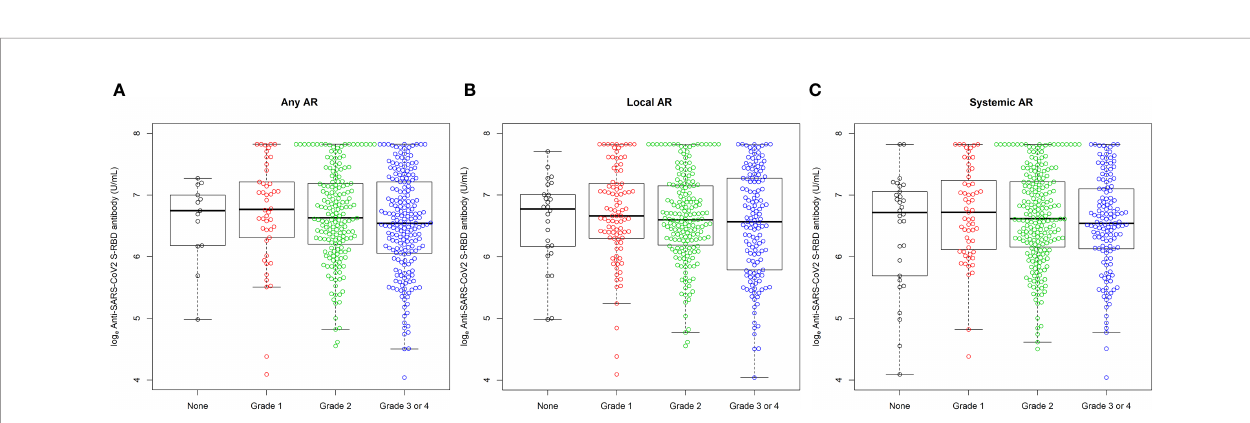
FIGURE 1 | Distribution of log-transformed (ln) antibody concentration at 4 weeks after the second injection of ChAdOx1 nCoV-19 vaccine according to (A) age (years) group, (B) sex, and (C) body mass index (kg/m 2 ) group. Antibody was expressed as the natural logarithm of concentration of anti-SARS-CoV-2 S protein RBD. Upper and lower whiskers represent the highest and lowest data points, respectively, excluding any outliers. The horizontal lines in the middle, top, and bottom of the box represent the median, 75 th percentile, and 25 th percentile, respectively.